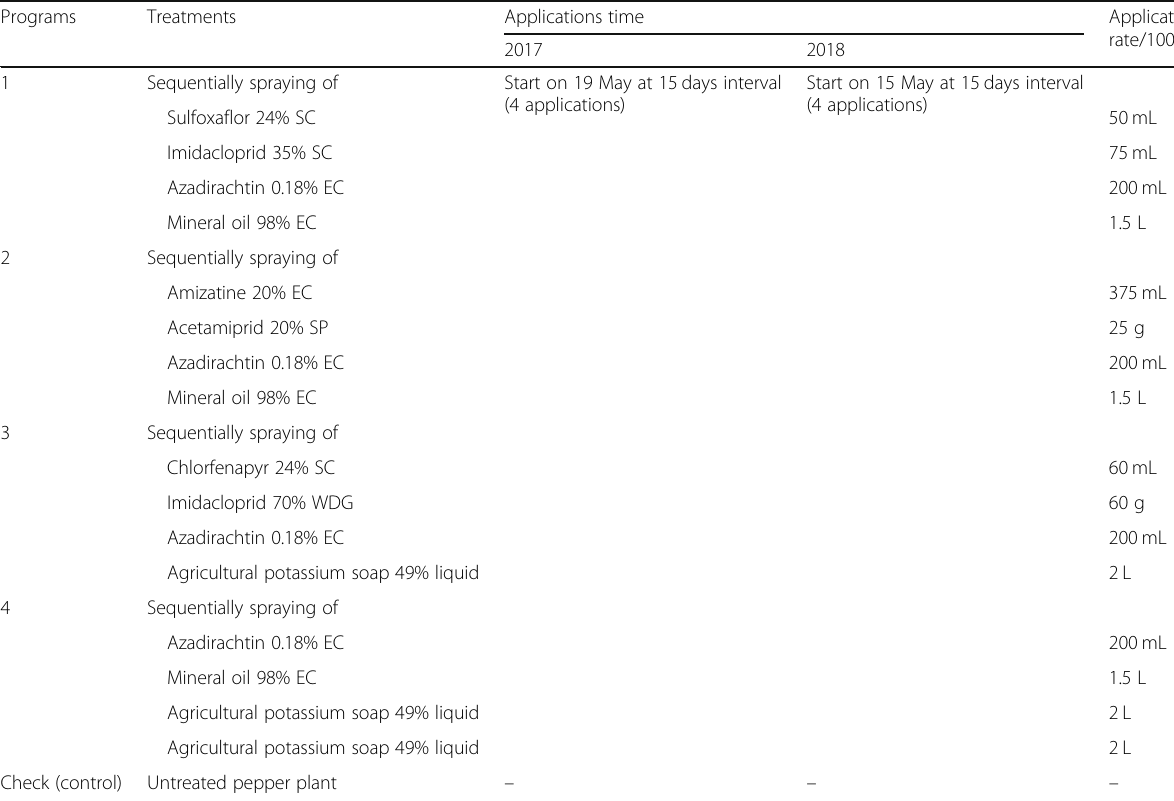
Table 2 Application of four programs for Frankliniella occidentalis management on pepper plants during the two seasons of 2017 and